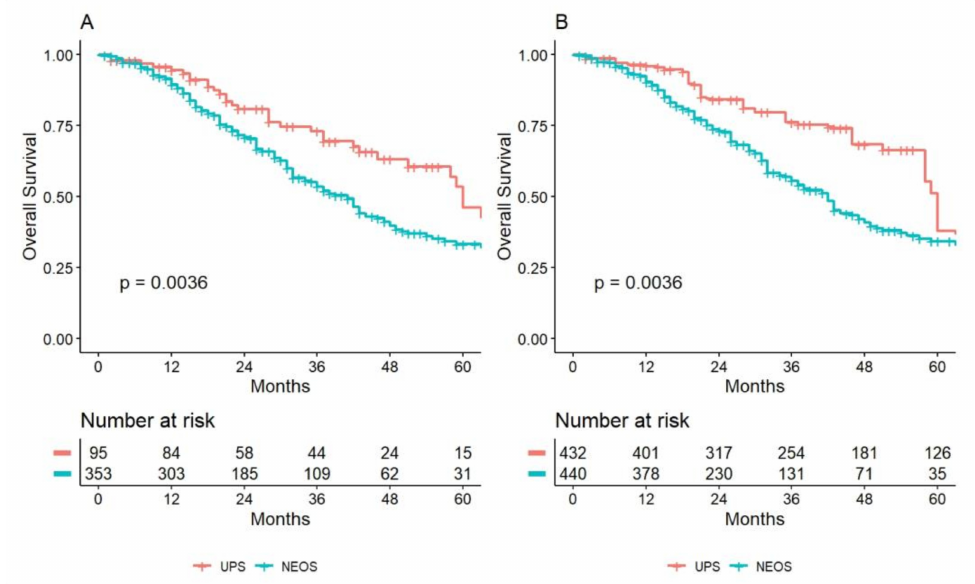
Figure 1. Overall survival is depicted among the two groups ( A ) before and ( B ) after the Inverse Probability Weighting. (UPS Upfront Surgery; NEOS neoadjuvant plus surgery).